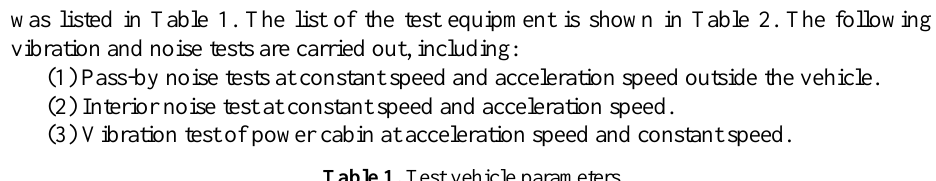
Table 1. Test vehicle parameters